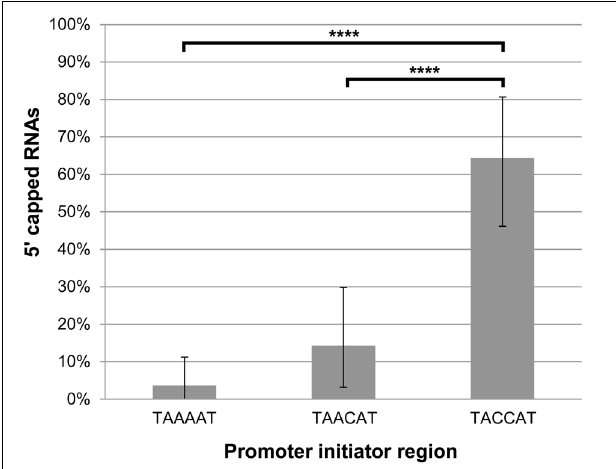
FIGURE 7 | The lengths of the adenosine stretches within the promoter initiator regions of pGKL mRNAs inversely correlate with the proportion of their 5 (cid:48) capping. The presence of 5 (cid:48) RNA caps was monitored using 5 (cid:48) RACE analysis of the G418 R gene from the IFO1267_pRKL1-1 strain (TAAAAT initiator region), IFO1267_pRKL1-2 strain (TAACAT initiator region), and IFO1267_pRKL1-3 strain (TACCAT initiator region), followed by cloning and sequencing of individual cDNA clones (26 clones for each strain). Bars represent the frequency (in %) of 5 (cid:48) RNA capping, with the error bars depicting the 95% confidence intervals calculated using the adjusted Wald method. The results were statistically evaluated using two-tailed Fisher’s exact test with a 95% confidence interval. ∗∗∗∗ Significance level p <